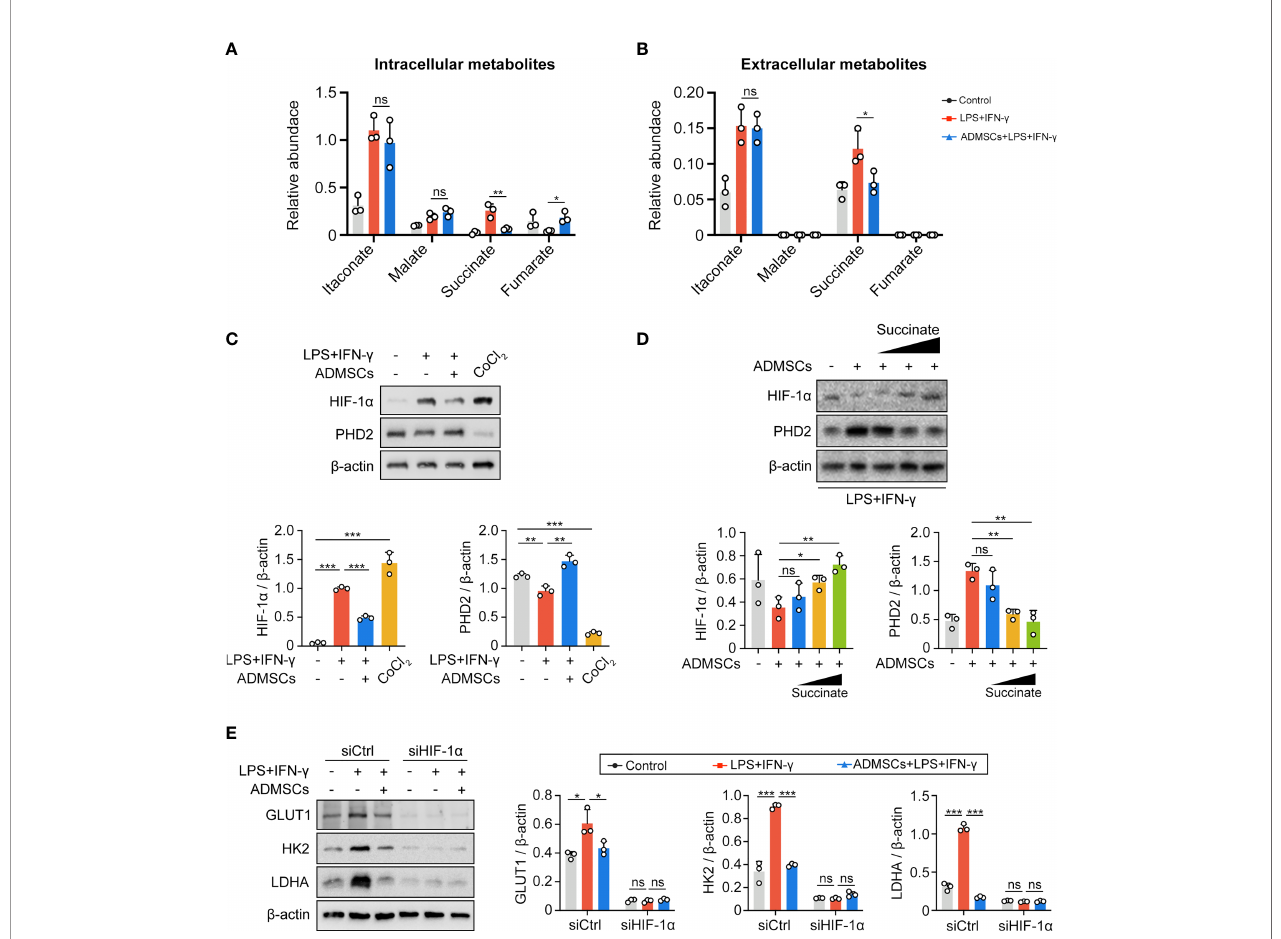
FIGURE 4 | ADMSCs reprogrammed glycolysis in M1-BMDMs through succinate-dependent PHD2/HIF-1 a pathway. (A, B) Intracellular (A) and extracellular (B) metabolites of BMDMs with different treatment. (C) HIF-1 a and PHD2 levels in BMDMs with different treatments. (D) Protein levels of HIF-1 a and PHD2 in BMDMs supplemented with ADMSCs and different concentrations of succinate. (E) Protein levels of glycolytic enzymes (GLUT1, HK2 and LDHA) in BMDMs transfected with HIF-1 a siRNA. (*p < 0.05; **p < 0.01; ***p < 0.001; ns, no signi fi